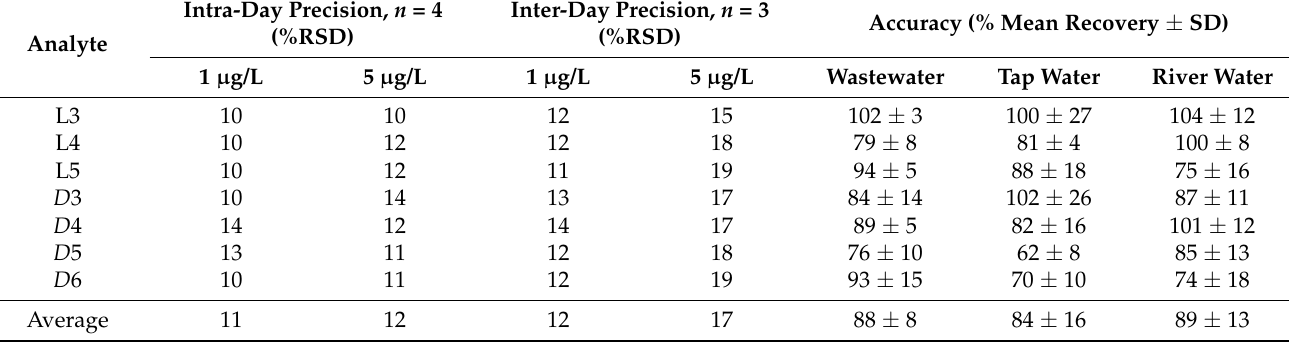
Table 4. Precision and accuracy parameters.